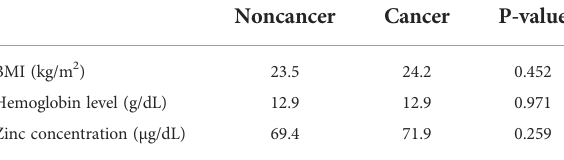
TABLE 2 Relationship between BMI, hemoglobin levels, and serum zinc concentrations in cancer and noncancer patients.